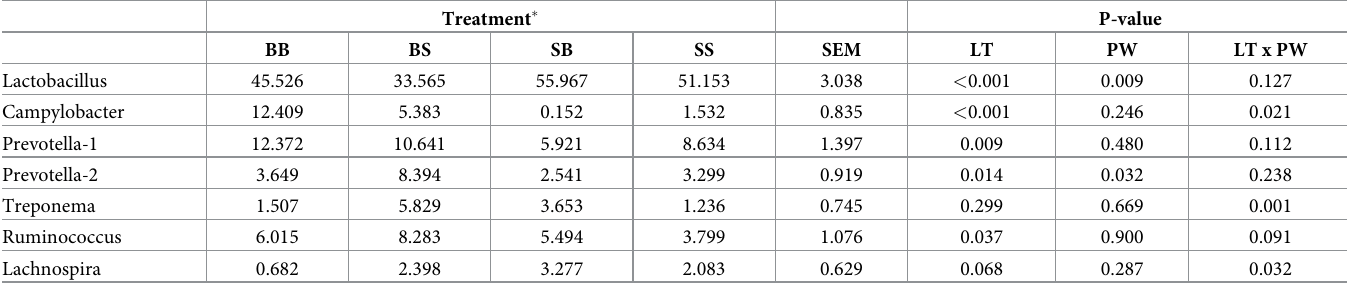
BB basal sow, basal pig; BS basal sow, supplemented pig; SB supplemented sow, basal pig; SS supplemented sow, supplemented pig; LT, lactation diet; PW, post-weaning diet � A total of ten replicates were used per